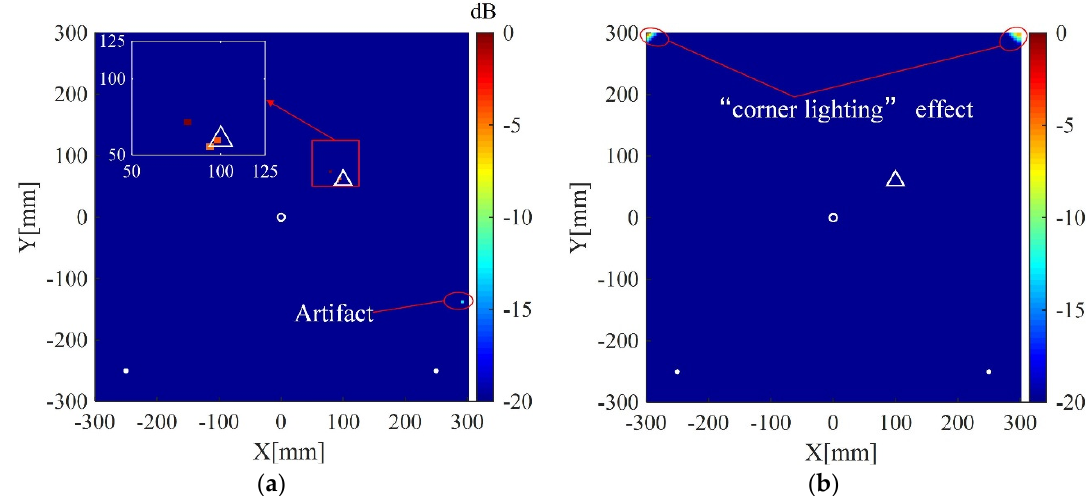
Figure 13 . ( a ) Imaging result of the weighted structured sparse reconstruction ‐ based Lamb wave imaging method using uniform weights (the location error is 20 mm); ( b ) Imaging result of the weighted structured sparse reconstruction ‐ based Lamb wave imaging method using uniform weights and original scattering signals (the scatter cannot be located). White dots denote locations of PZT receivers, the white circle denotes the location of the excitation source, and the white triangle denotes the location of the scatterer.